Question: Sum up the contents of this chart in one sentence.
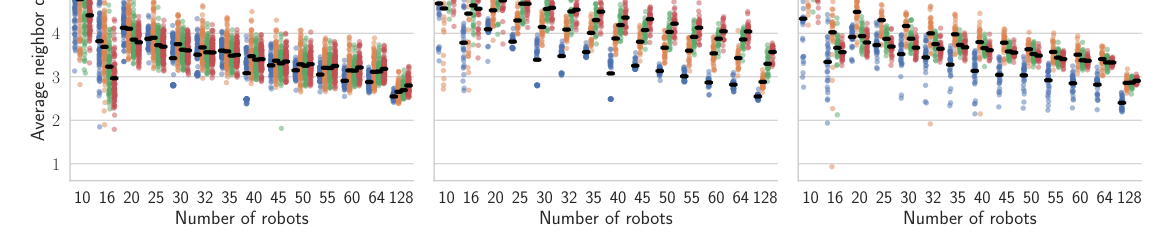
Answer: The percentage of successful missions when scaling the number of worker robots and map size in urban (A), maze (B), and forest (C). Average neighbour distance for all arena configurations are shown in (D-F). As the number of robots increase the success rate improves which is synchronous to the drop in average neighbour distance, indicating that sufficient collective sensing area is required to succeed in the mission.